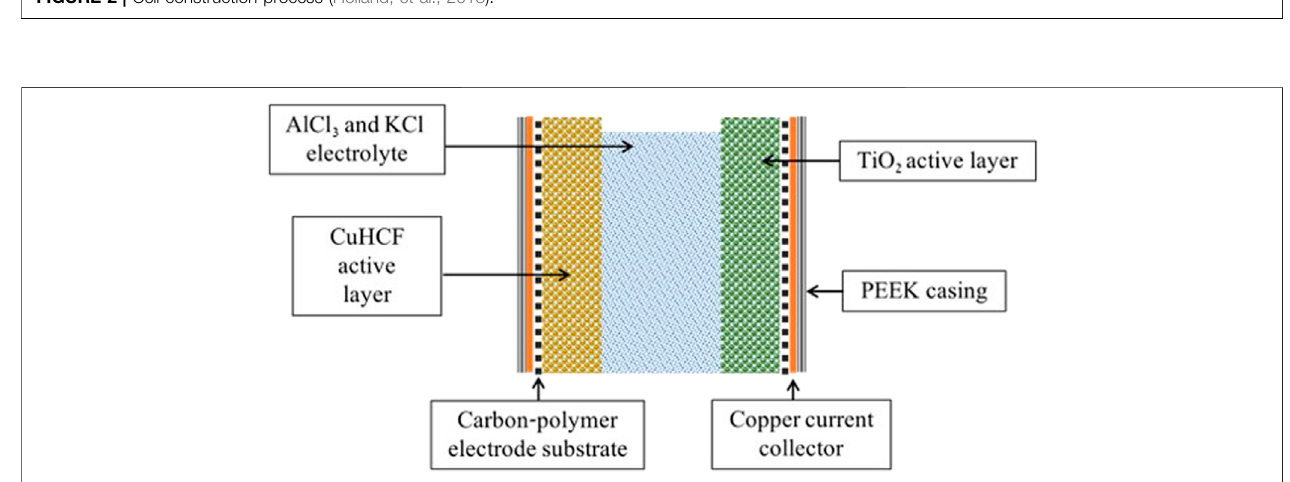
FIGURE 2 | Cell construction process (Holland, et al., 2018).